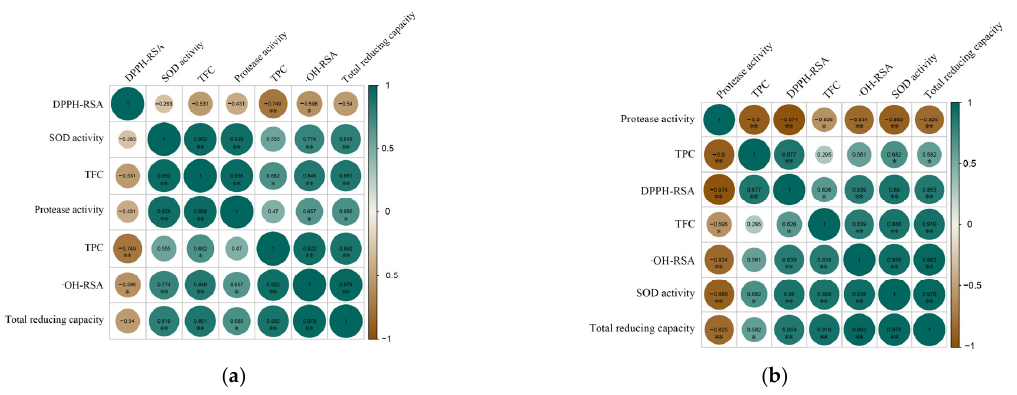
Figure 8. Correlation analysis between the active components of ‘Xuehua’ pear ferment and antiox ‐ idant capacity during the simulated digestion in vitro. ( a ) indicates simulated gastric digestion; ( b ) indicates simulated intestinal digestion. * indicates significant correlation ( p < 0.05), ** indicates significant correlation ( p <